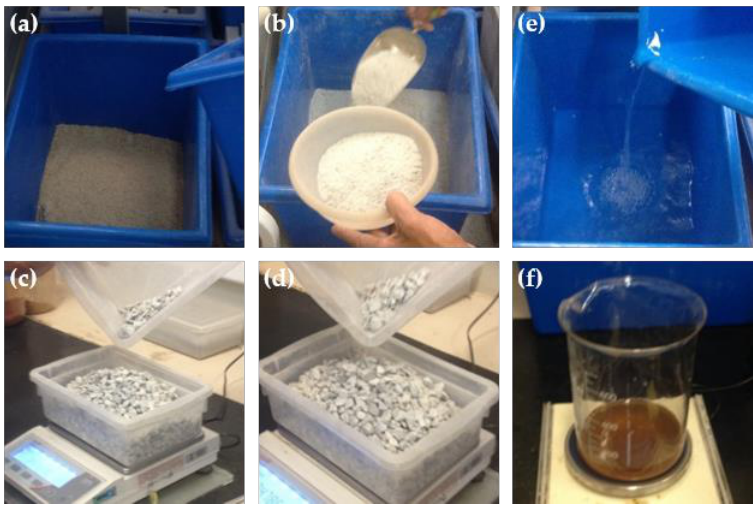
Figure 5. Inputs used in low-carbon concrete ( a ) fine sand, ( b ) stone powder, ( c ) and ( d ) coarse aggregate with dimensions of 4.8 to 9.5 mm and 9.5 to 19.5 mm respectively, ( e ) water and ( f ) superplasticizer additive.